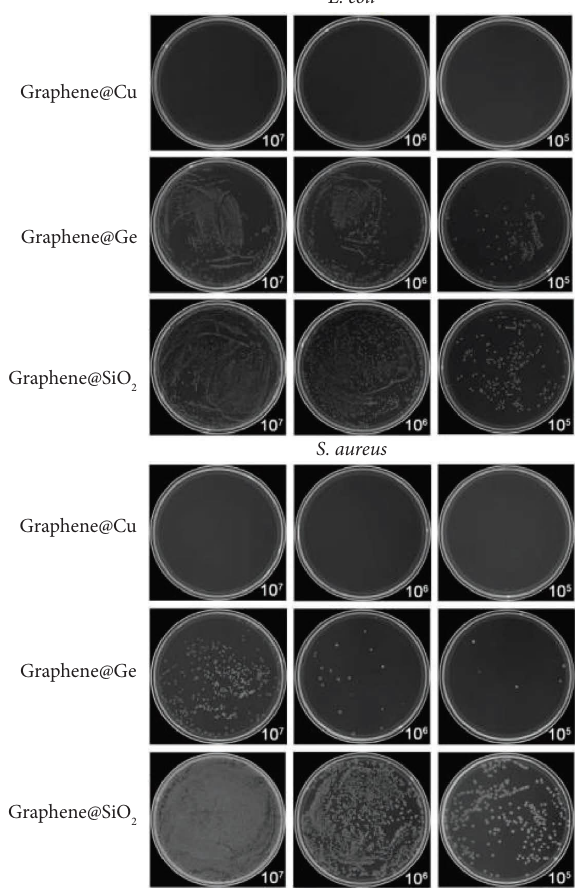
Figure 5: Photographs of E . coli (top) and S . aureus (bottom) cultured on the three types of graphene flms (reprinted from Li et al. [77] following the Creative Commons Attribution (CC BY) license (https://creativecommons.org/licenses/by/4.0/) (accessed on 4 May